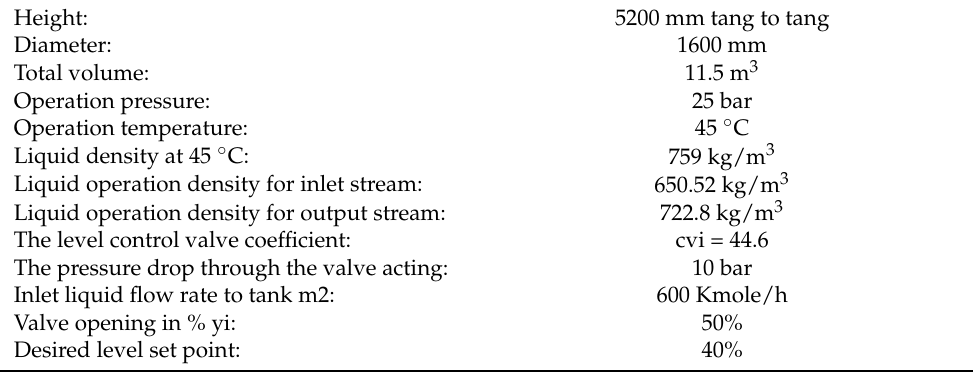
Table 1. Parameters of the D5204 system in process unit of Basrah Refinery.